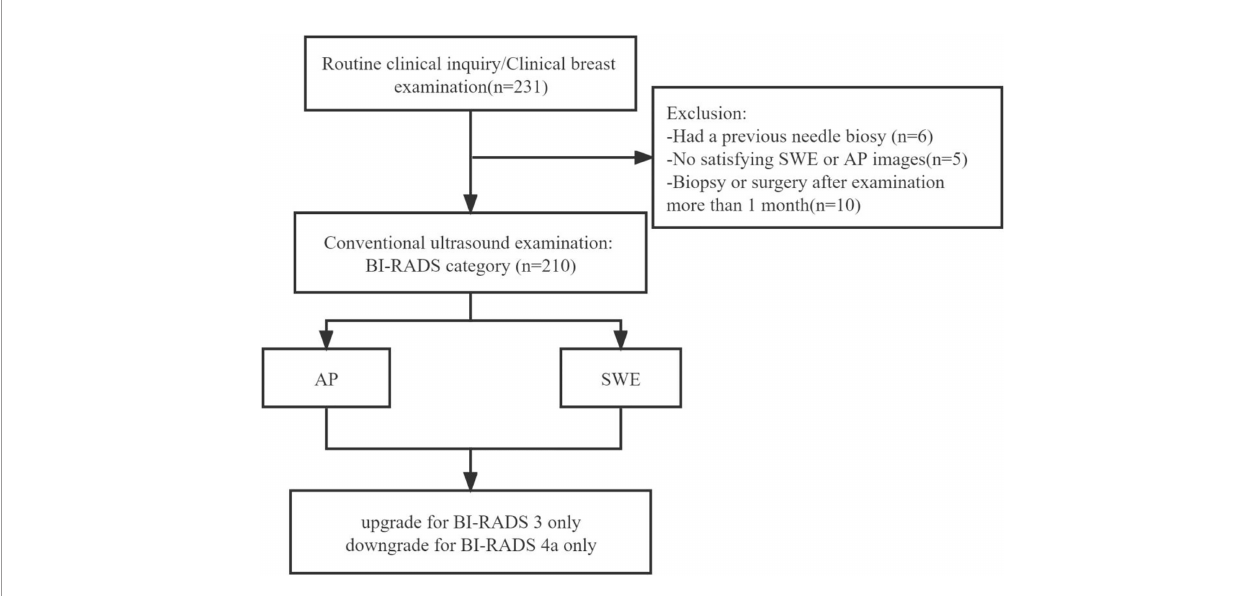
FIGURE 3 | Flow chart for the selection of breast lesions.